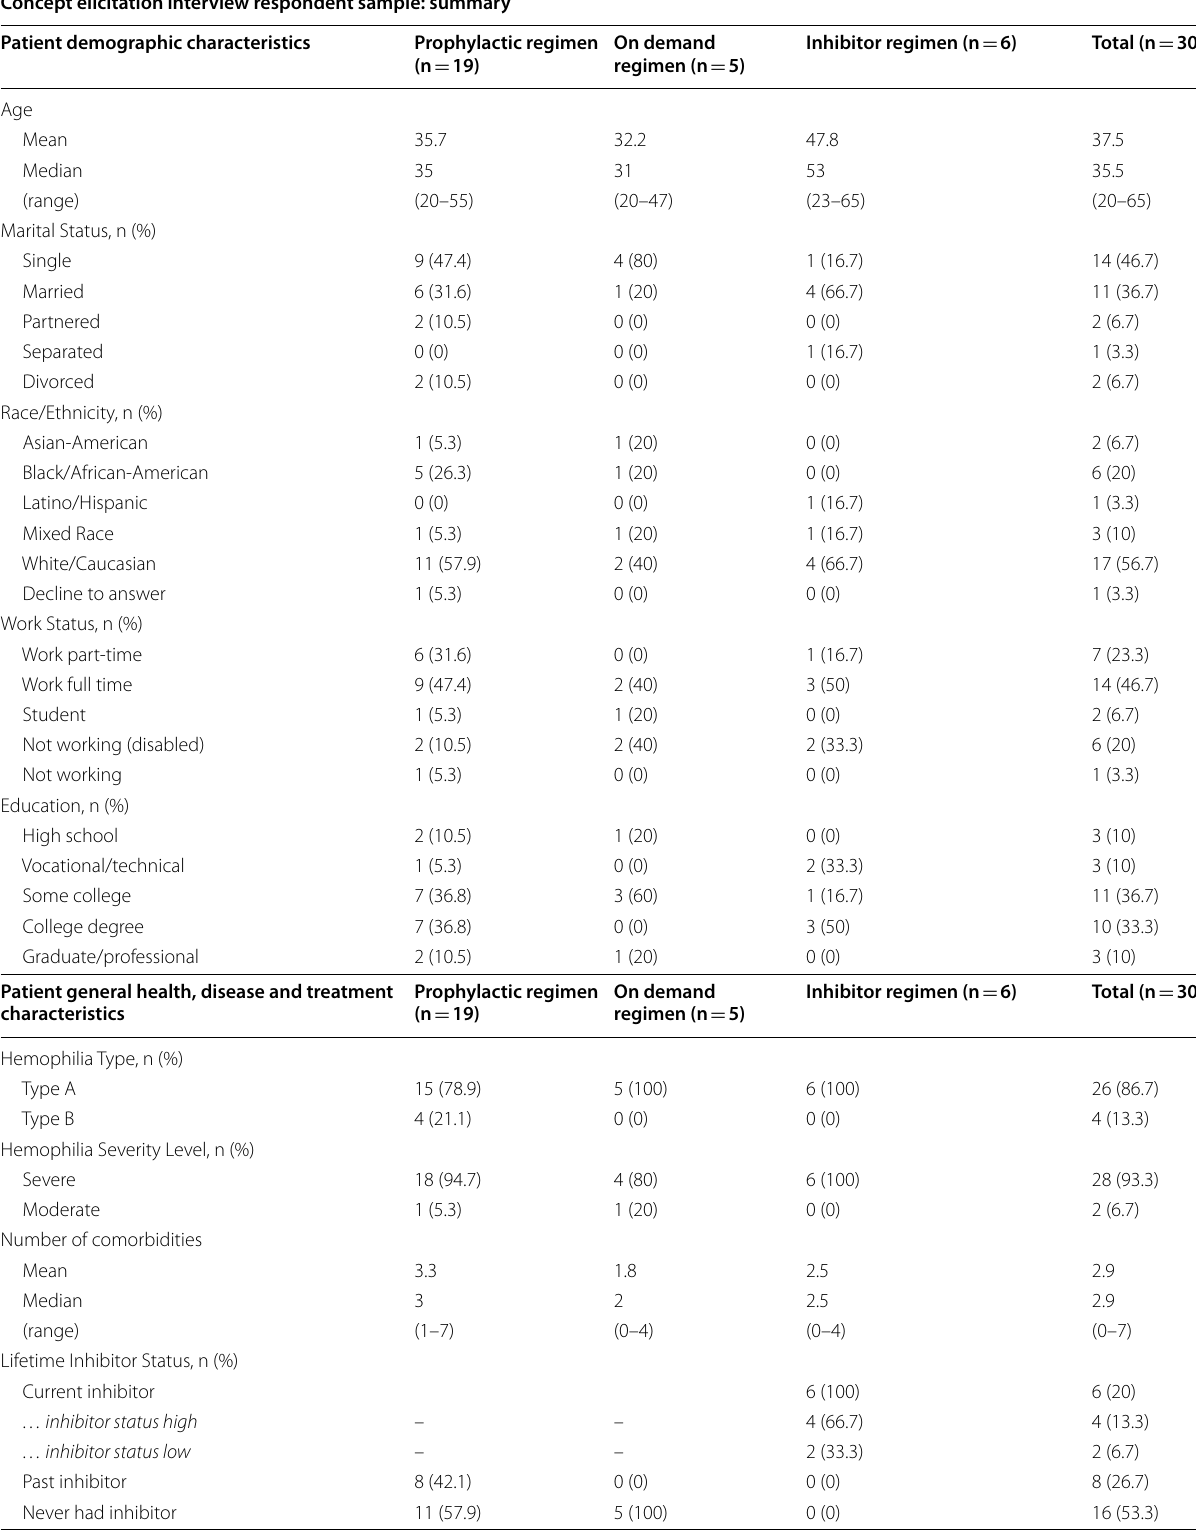
Table 1 Concept elicitation and cognitive debriefing adult samples—summary Concept elicitation interview respondent sample: